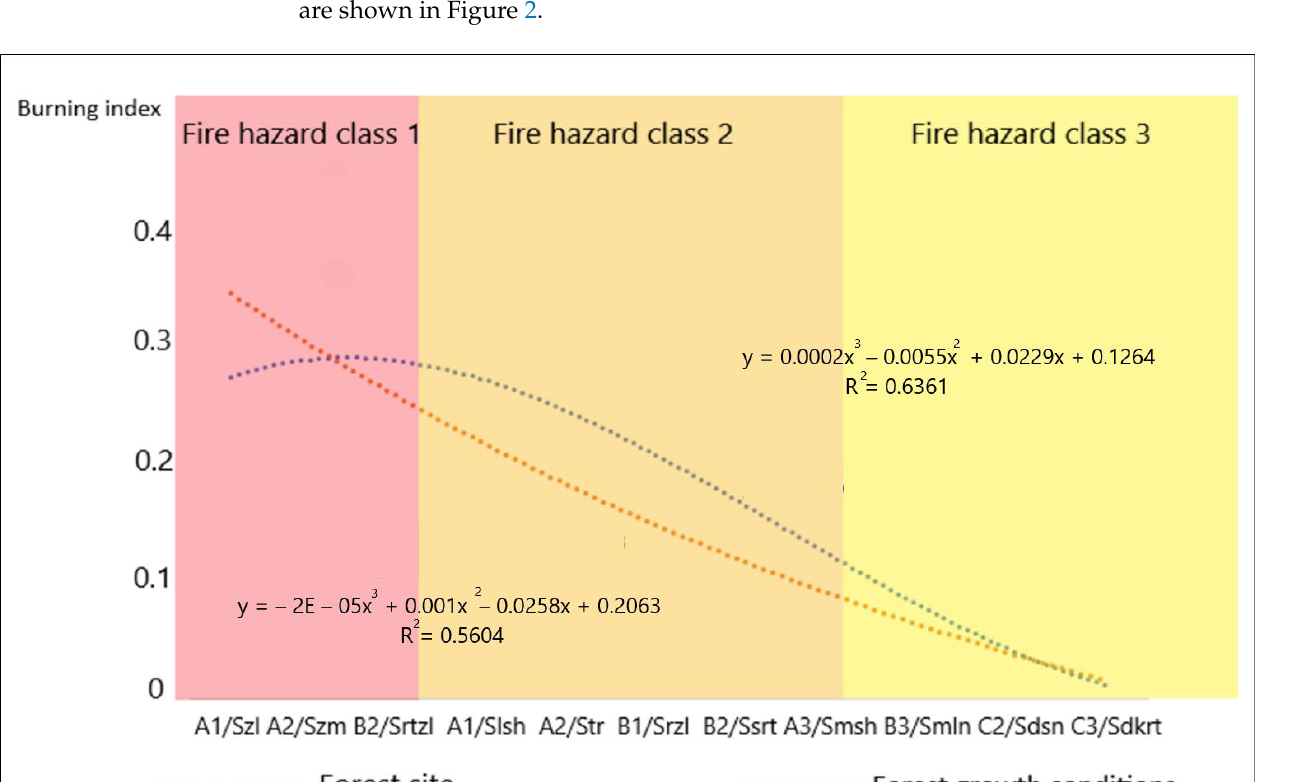
Figure 2. Aligned values of burning indices by forest site (blue) and forest growth conditions (red).